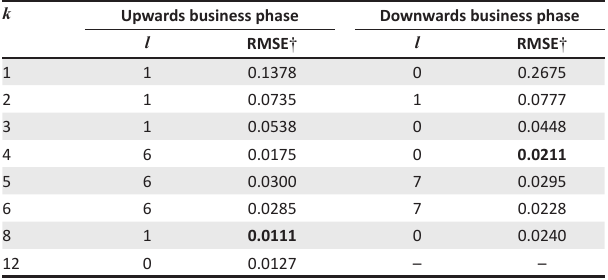
† , RMSE values in bold indicate the minimum value for a particular set of models; RMSE, root mean squared error.